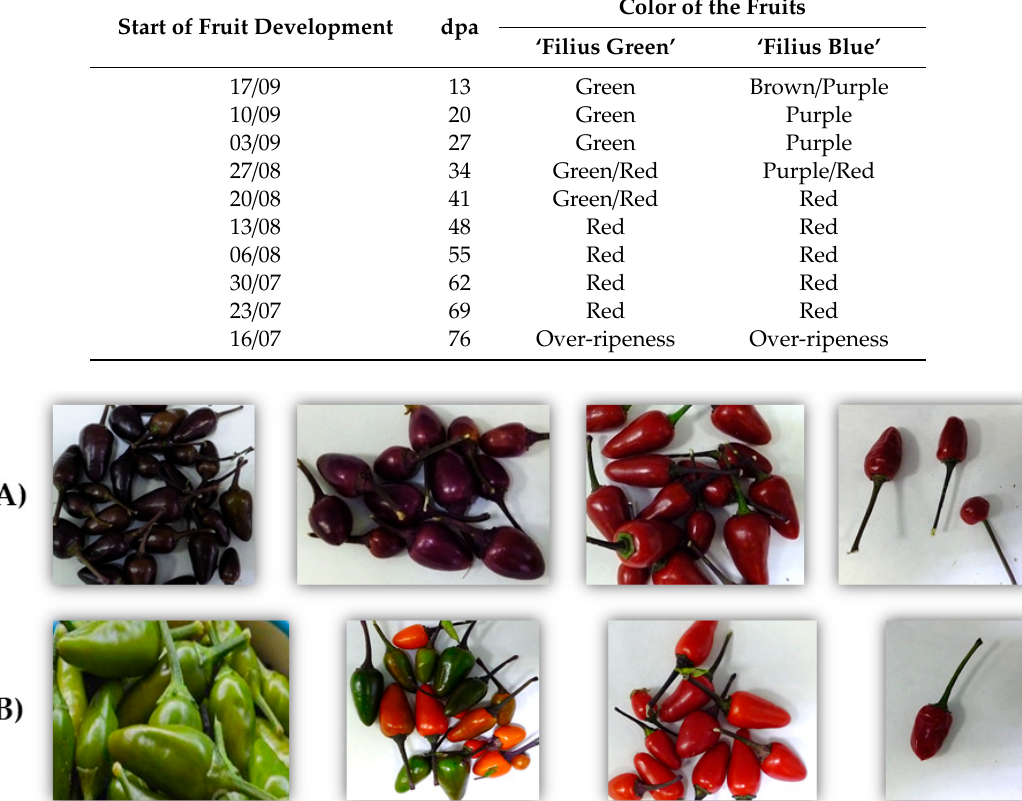
Figure 1. Changes in the color of the fruits in both varieties over their maturation process. ( A ) Purple variety ‘Filius Blue’; ( B ) green variety ‘Filius Green’. The images of each variety were taken at 13, 34, 55 and 76 dpa from left-to-right, respectively. The respective UHPLC-PDA chromatograms ( λ = 280 nm) are included in Figure S1 of Supplementary Material.